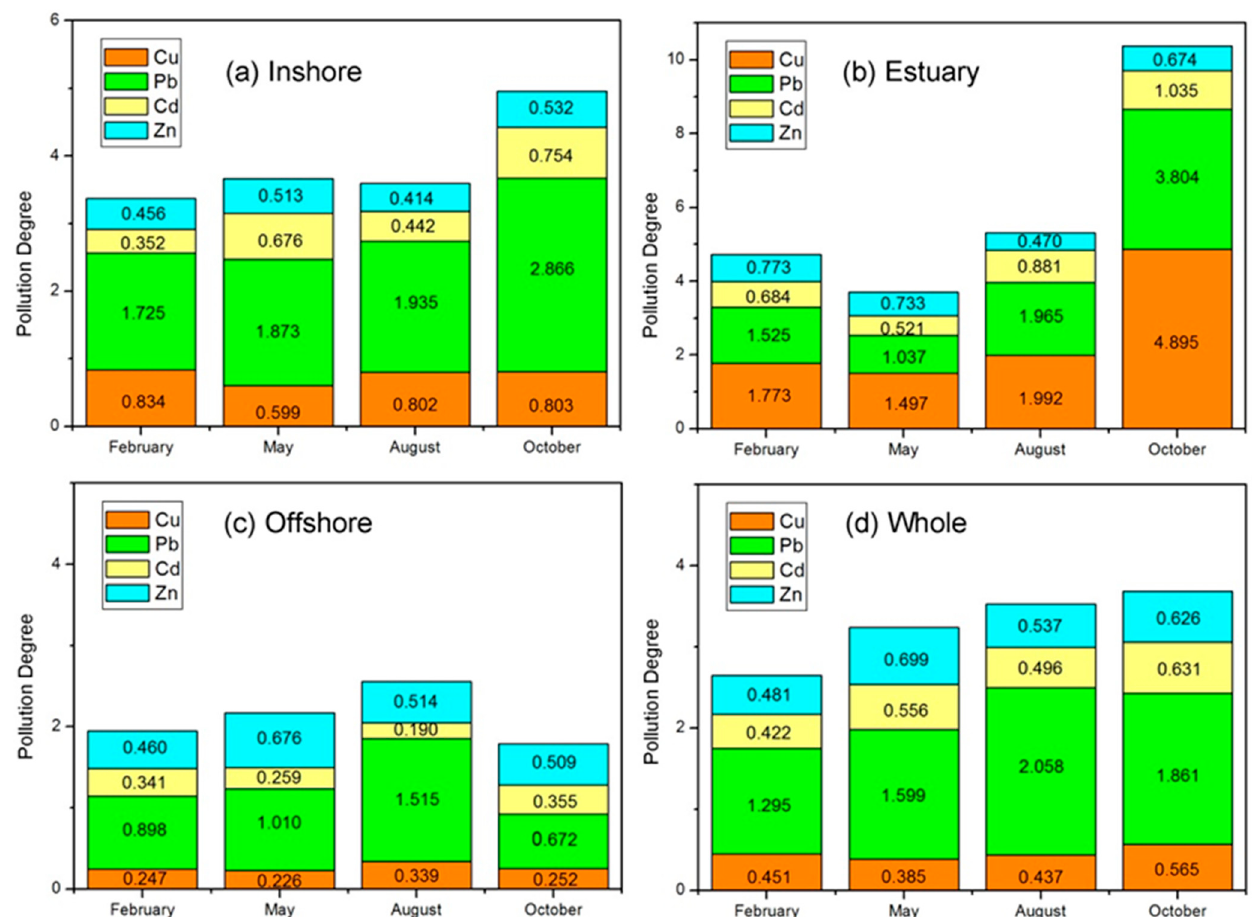
Figure 8. Pollution factors for dissolved heavy metals in different regions of Liaodong Bay at different months.